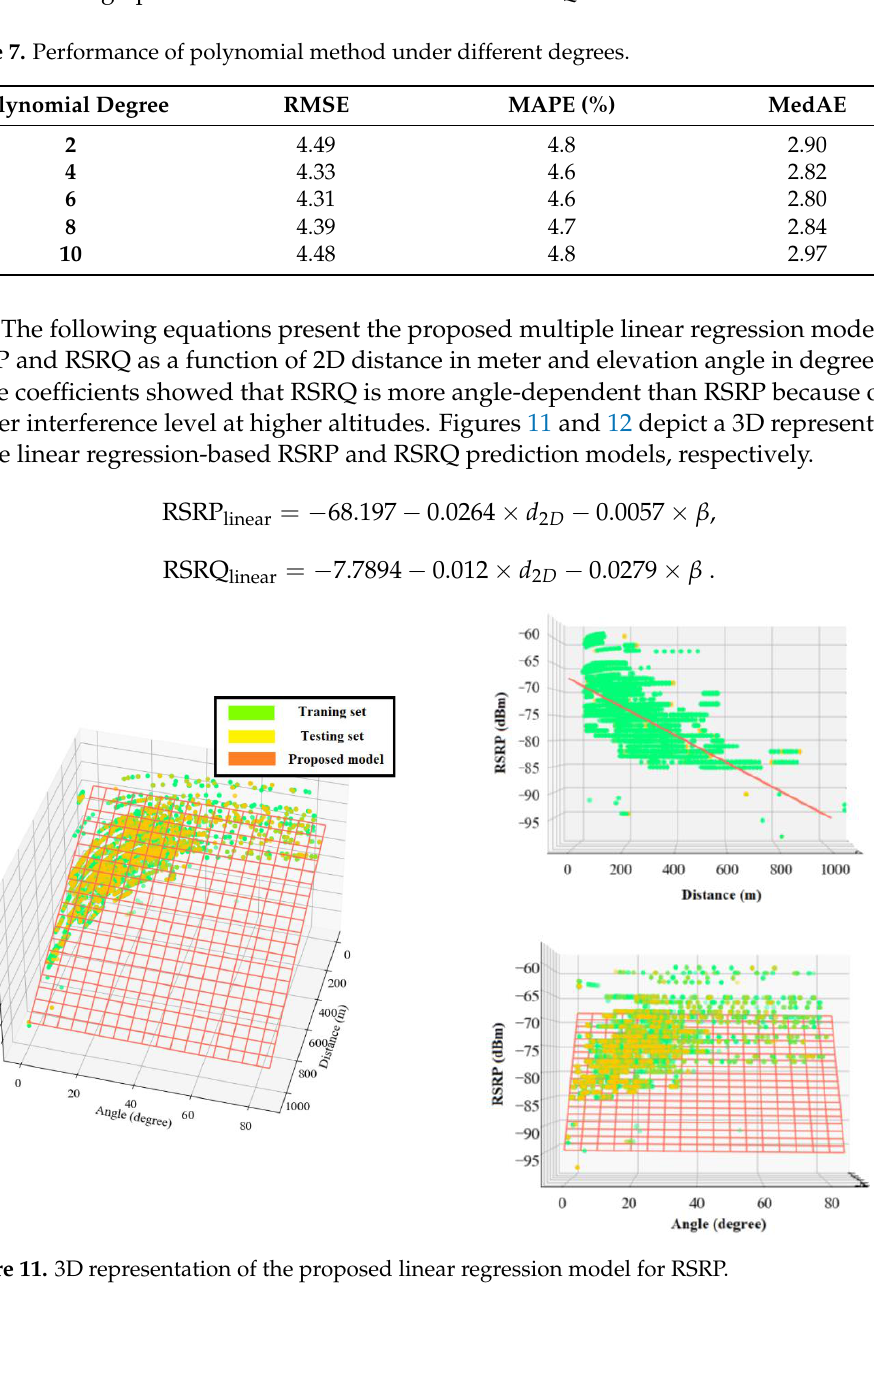
Figure 12. 3D representation of the proposed linear regression model for RSRQ. The following equations present the proposed polynomial-based RSRP and RSRQ prediction models, and Figures 13 and 14 show a 3D representation of the proposed models for the RSRP and RSRQ, respectively. RSRP polynomial = −65.048 − 4.67 × 10 −2 × 𝑑 2𝐷 + 0.11 × 𝛽 + 3.22 × 10 −5 × 𝑑 2𝐷2 − 4.35 × 10 −4 × 𝑑 2𝐷 × 𝛽 − 2.04 × 10 −3 × 𝛽 2 ,